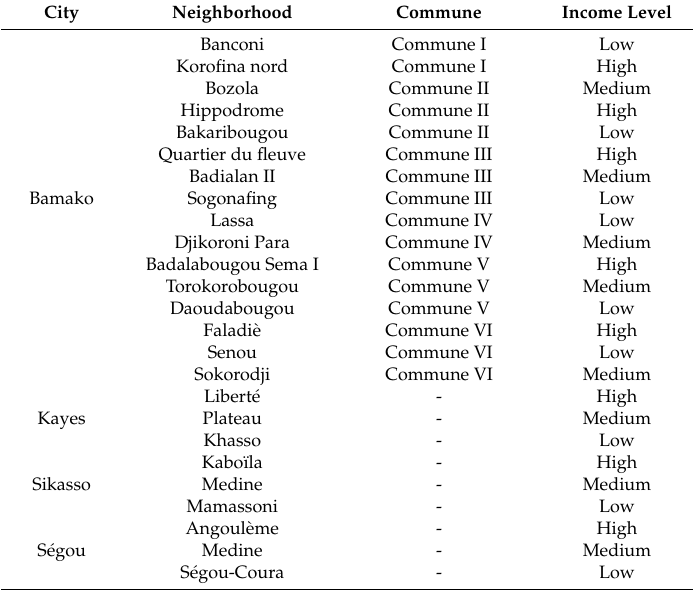
Table A1. List of selected neighborhoods, and associated income level, per